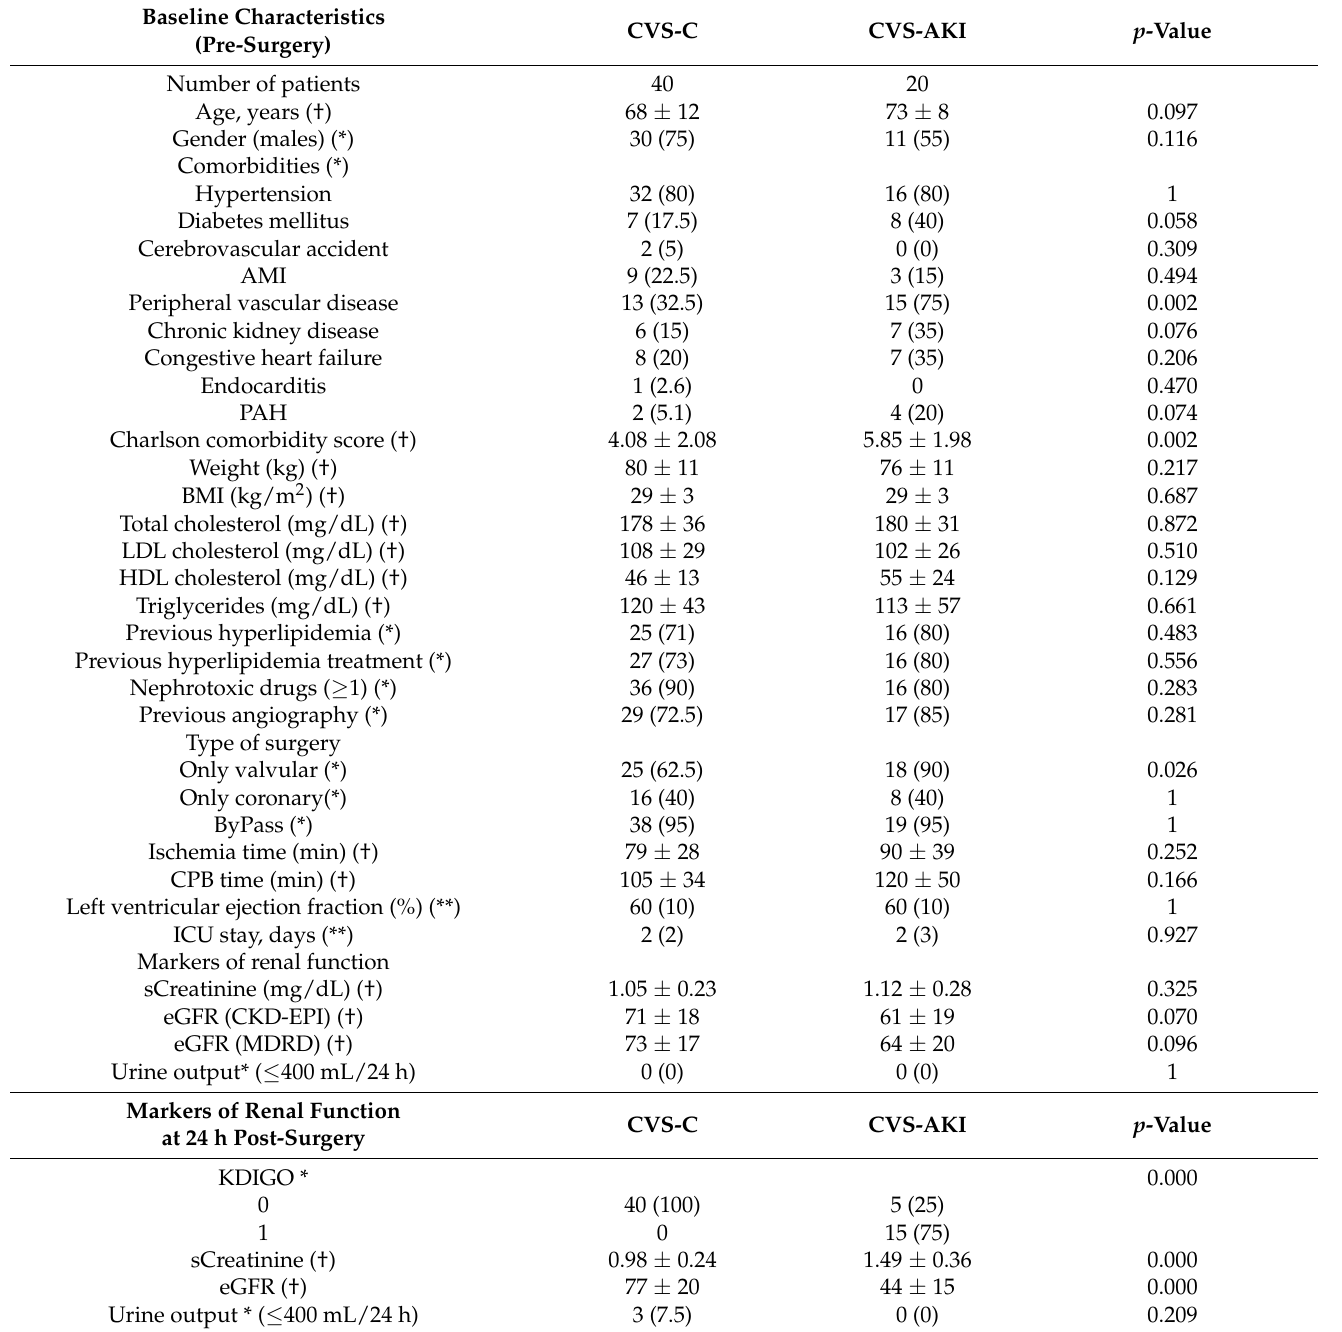
Table 1. Baseline characteristics (pre-surgery) and markers of renal function at 24 h post-surgery of patients included in the